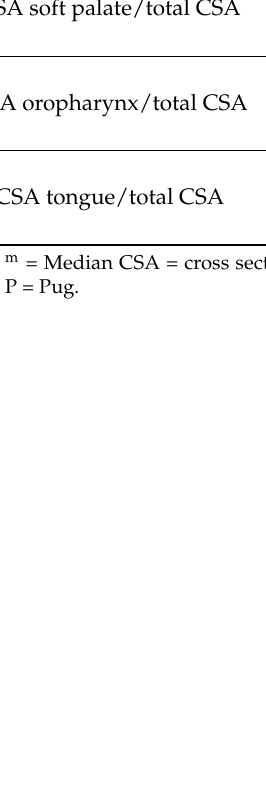
Table 5. Summary of cross-sectional area